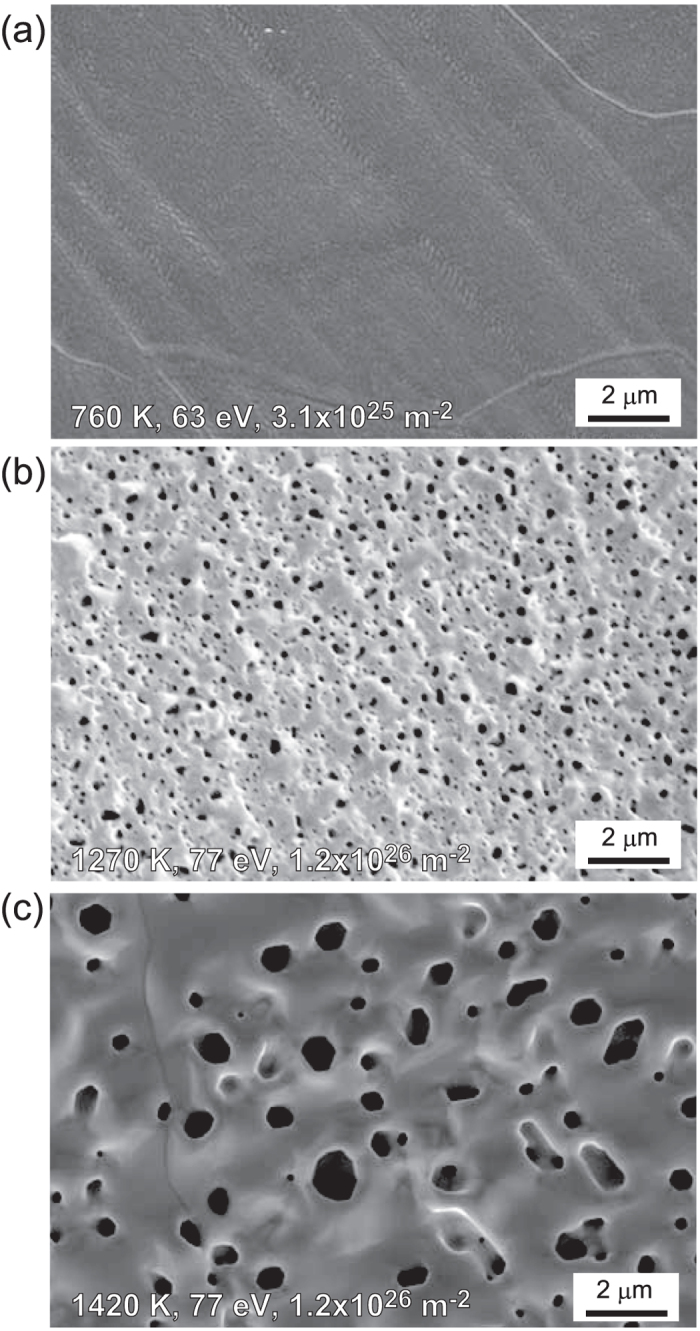
SEM micrographs of Ta samples exposed to the He plasmas at the surface temperatures of (a) 760, (b) 1270, and (c) 1420 K. The incident ion energy and the He fluence were (a) 63 eV and 3.1 × 1025 m−2, respectively, and (b,c) 77 eV and 1.2 × 1026 m−2, respectively.